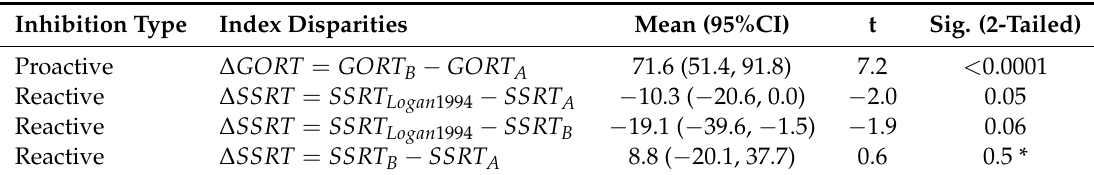
Table 3. Paired t -test results of the internal reactive and proactive inhibition indices for Standard Stop Signal Task (SSST) with p ss = 0.25 (n =